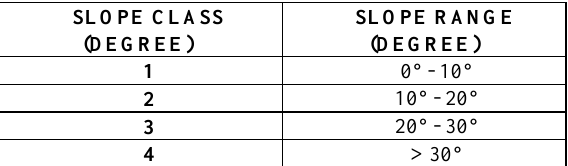
Figure 14. Orthophoto Generated at 40m Altitude